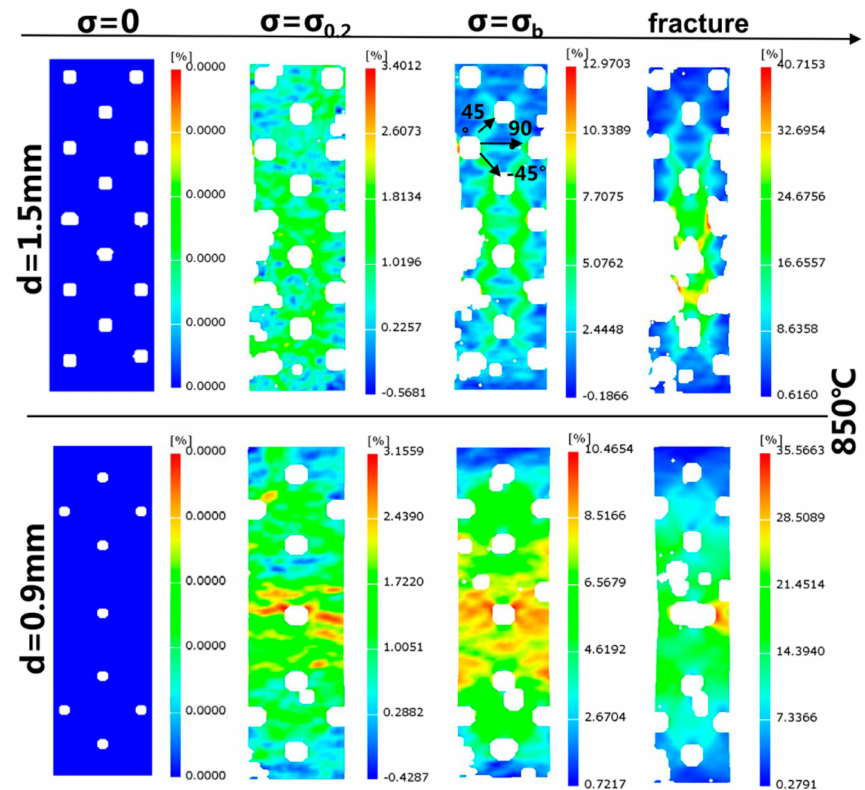
Figure 6. DIC strain nephograms of the specimen plates with overflow holes (d = 1.5 mm) and impact holes (d = 0.9 mm) at three di ff erent stress state stages ( σ = 0 / σ = σ 0.2 / σ = σ b ) and, before fracture, under three temperature